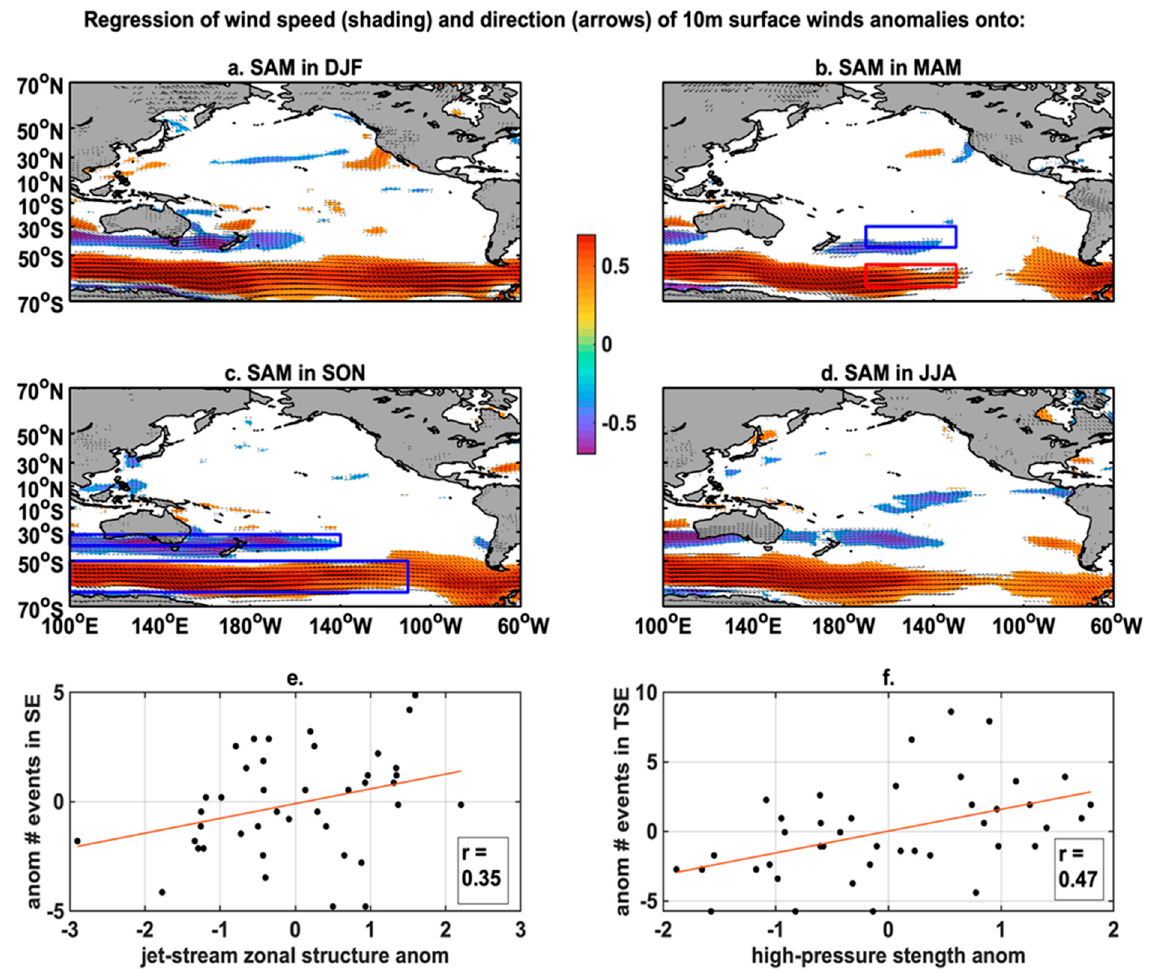
Figure 7. Regression of wind speed (shading) and direction (arrows) of 10-m surface winds anomalies onto the SAM index averaged in December–February ( a ), March–May ( b ), September–November ( c ), and June–August ( d ). Only regressions significant at the 95% level according to a Student t -test are displayed. Relationships ( e ) between the interannual anomalies of extreme open-ocean wave occurrence in the Pacific South-East in September–November and an index characterizing the SAM-induced zonal structure of the Southern-Hemisphere jet stream and ( f ) between the interannual anomalies of extreme open-ocean wave occurrence in the Pacific Tropical South-East in March–May and an index characterizing the jet-stream meandering and related strength of the southern subtropical high-pressure system.